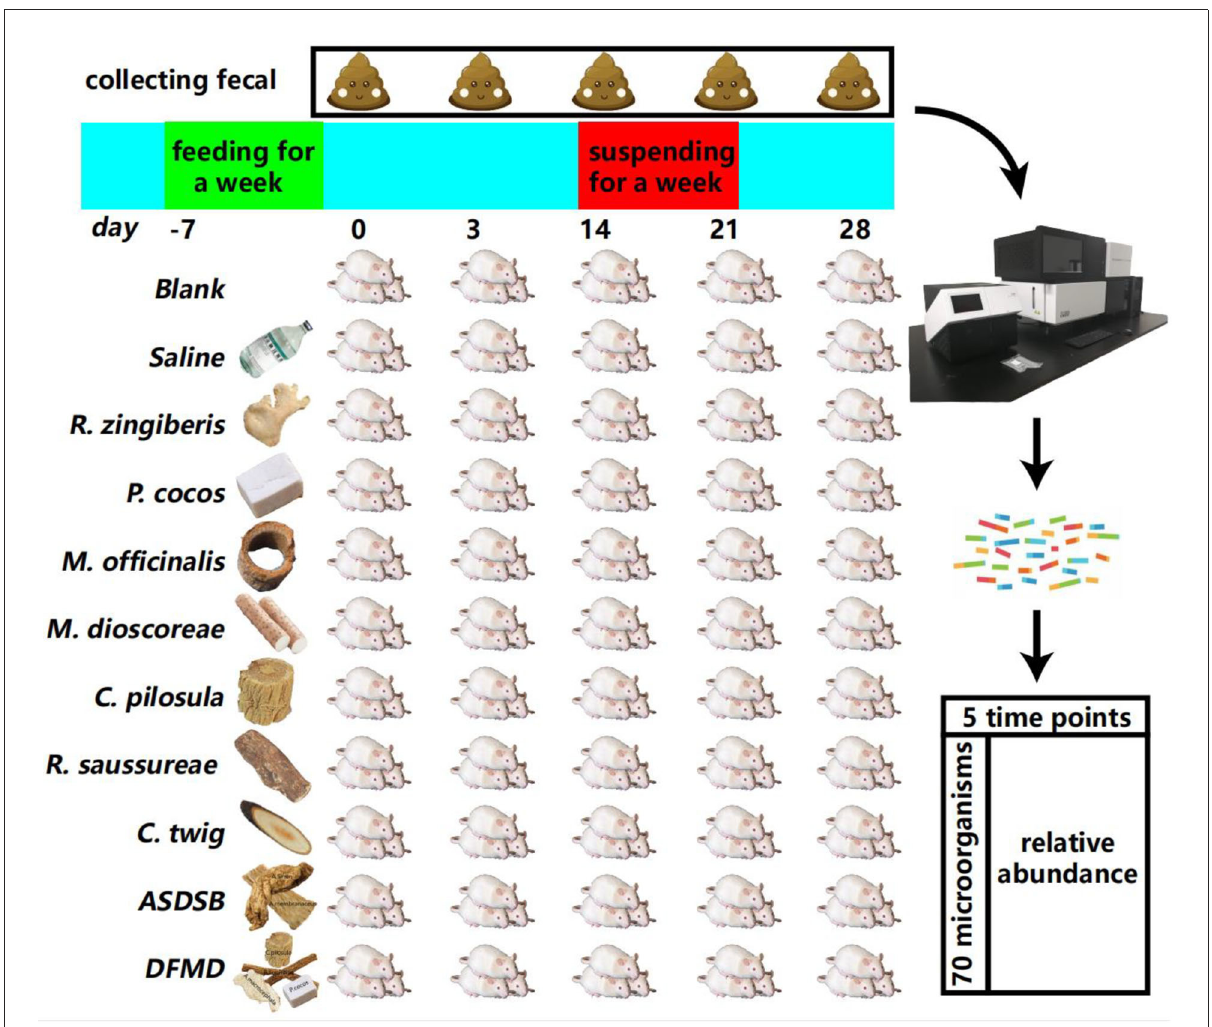
FIGURE1 Experimental design and the microorganism relative abundance calculation for 70 species over five time points, where ASDSB represents the Dang Gui Bu Xue Decoction, and DFMD represents the Sijunzi